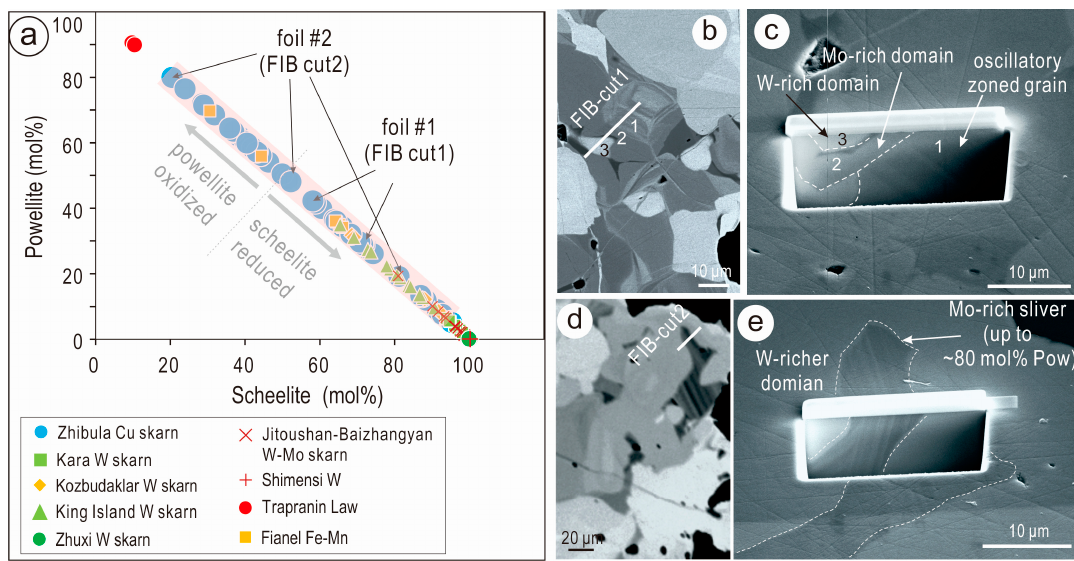
Figure 8. ( a ) Plot of wt.% MoO 3 vs. wt.% WO 3 for Zhibula scheelite-powellite (EPMA data) showing a range straddling from ~5 mol.% to 80 mol.% Pow (highlighted by pink overlay). The dataset thus represents one of the widest spreads along the Sch-Pow tie-line recorded from a single occurrence. The composition of areas chosen for nanoscale investigation is indicated. Selected examples of scheelite-powellite from published data are shown for comparison: Kara [10], Kozbudaklar [30], King Island [9], Zhuxi [31], Jitoushan-Baizhangyan [5], Shimensi [32], Trapranin Law [33], and Fianel [8]. ( b – e ) BSE images (left) and secondary electron (SE) images (right) showing plan view and depth (cross-section imaging) of the areas selected for nanoscale study. Tungsten and Mo distribution for the same areas are shown on EDS-SEM maps from Figure 4a,c. FIB—focused ion beam.